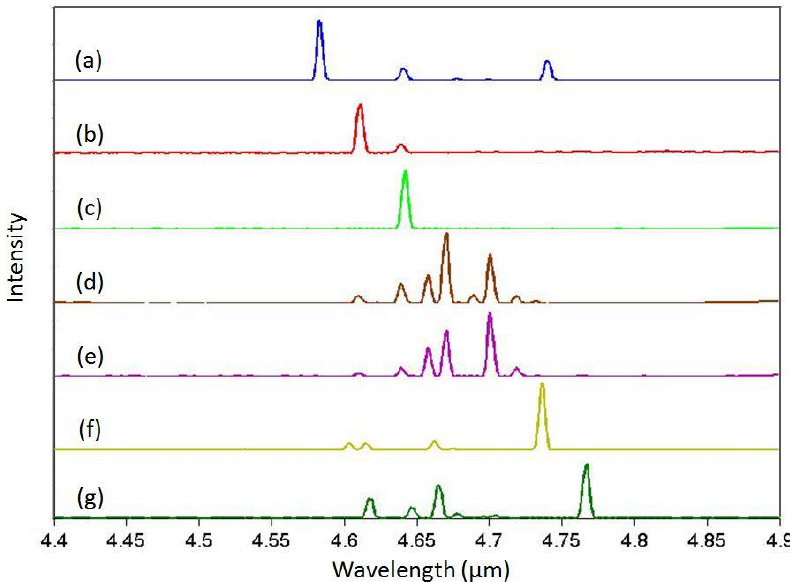
Figure 6. ( a – c ) Emission spectra by fixing the gain section current at 2.6 A and pumping the